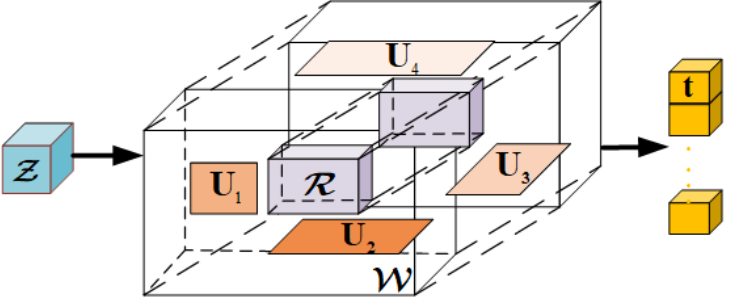
Figure 2. A representation of the Tucker decomposition-based classification